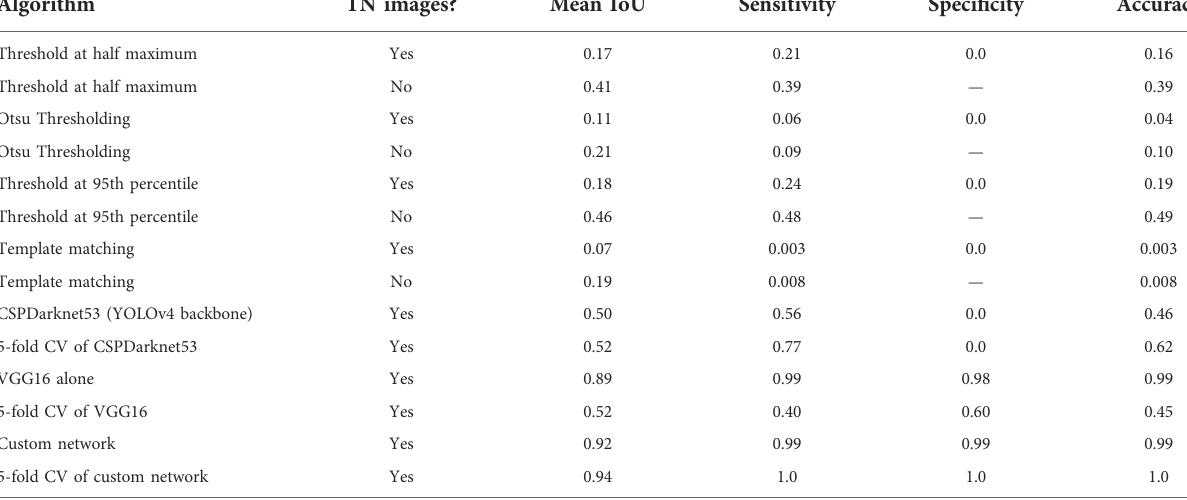
TABLE 2 Results of Algorithms